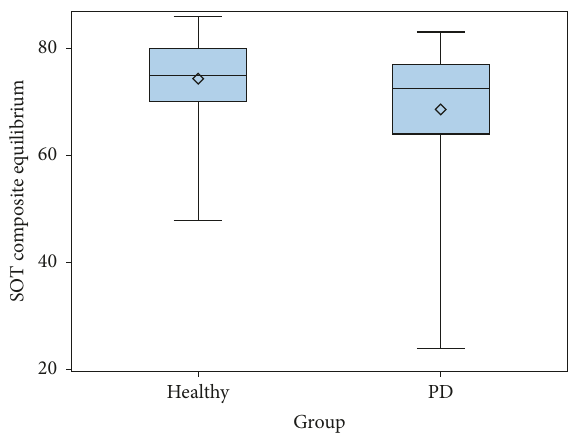
Figure 5: Comparative boxplot of sensory organization test composite equilibrium performance of Parkinson’s disease cohort based on the Hoehn and Yahr stage. Hoehn and Yahr stage 4 was not included in this analysis as only one participant was repre- sented in this stage. SOT, sensory organization